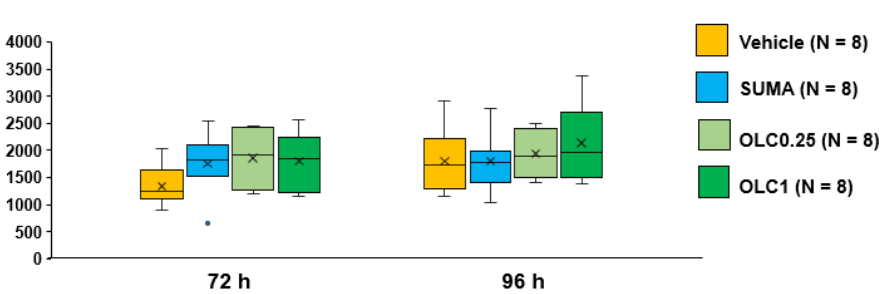
Figure 7. Ambulatory distance in the dark zone in each group. Data are plotted in the box-and- whisker box. The ordinate shows the sum of ambulatory distance travelled in the light zone during the evaluation period. Statistical analysis was performed using the two-way repeated measures ANOVA with effective matching to evaluate the effects of time and pharmacological interventions. Multiple comparisons were made by Sidak’s test for identical groups between 72 h and 96 h and by Dunnett’s test for different groups at the same timepoint. N = 8 in each group. Vehicle: Vehicle group, SUMA: Sumatriptan group, OLC0.25: Olcegepant 0.25 mg group, OLC1: Olcegepant 1 mg